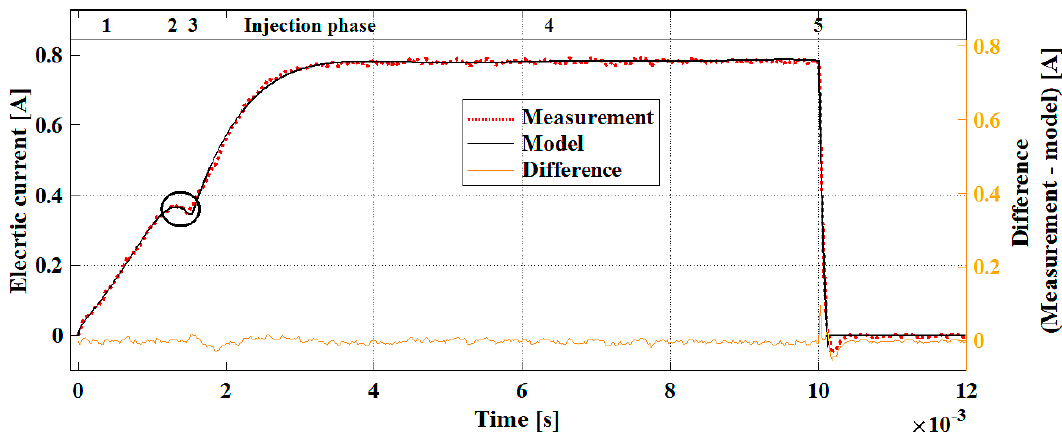
Figure 6. Measured and modeled electric current waveforms of the injector with the phases of differential equations marked.